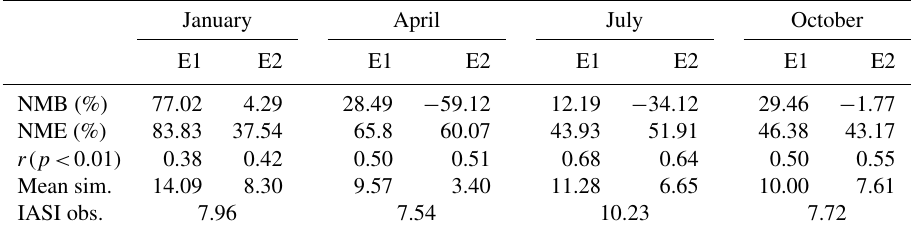
Figure 9. The NH 3 VCDs in the YRD region simulated with the two inventories by month. Table 4. Model performance statistics for the daily NH 3 VCDs from IASI observation and CMAQ simulation using the two inventories by